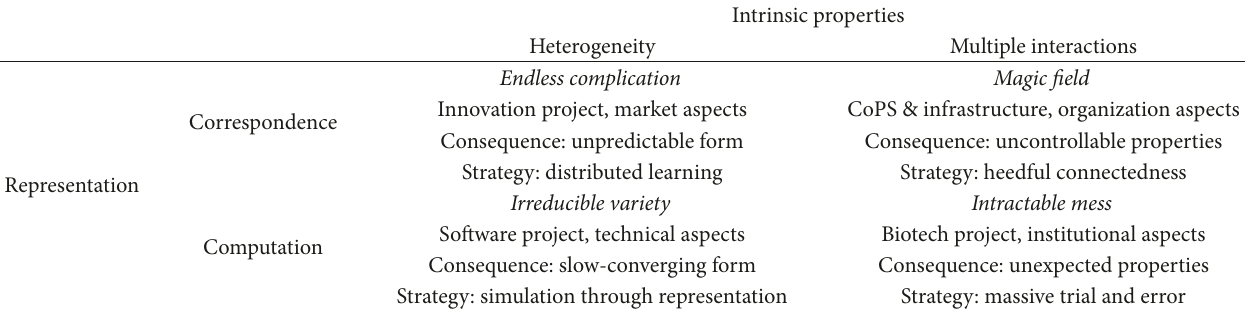
Table 1: Types of emergence processes and structural consequences as a function of antecedents, together with the most effective strategies for dealing with